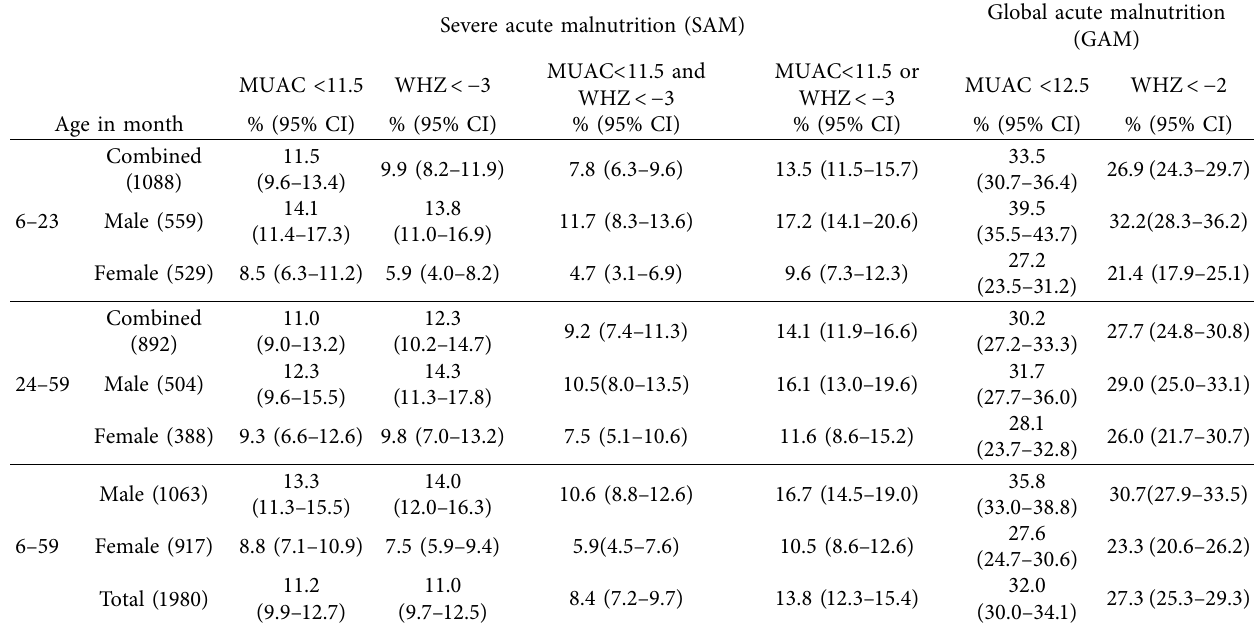
Table 3: Magnitude of acute malnutrition based on MUAC in cm and WHZ among children, South Gondar Zone, Ethiopia, 2017/18 ( n � 1980).